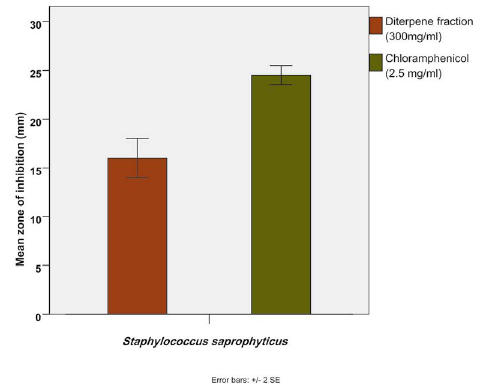
Fig. 2. Representative photo showing Table 4. MIC and MBC value of fruits of Platycladus